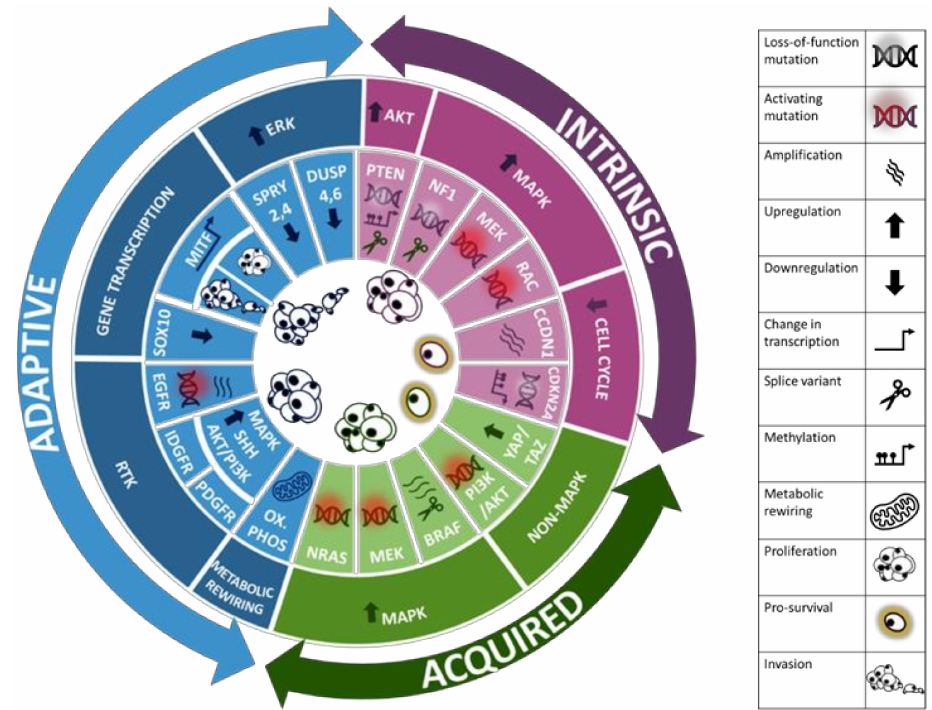
Figure 1. Schematic representation of the three subtypes of resistance mechanism against targeted therapy in melanoma: intrinsic, adaptive, and acquired. The main pathways and mutations account- ing for each subtype are